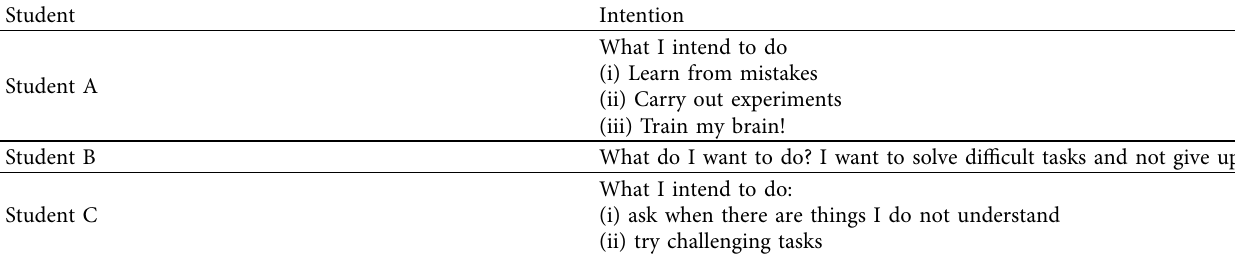
Table 3: Intentions for future physics lessons (samples; translated from